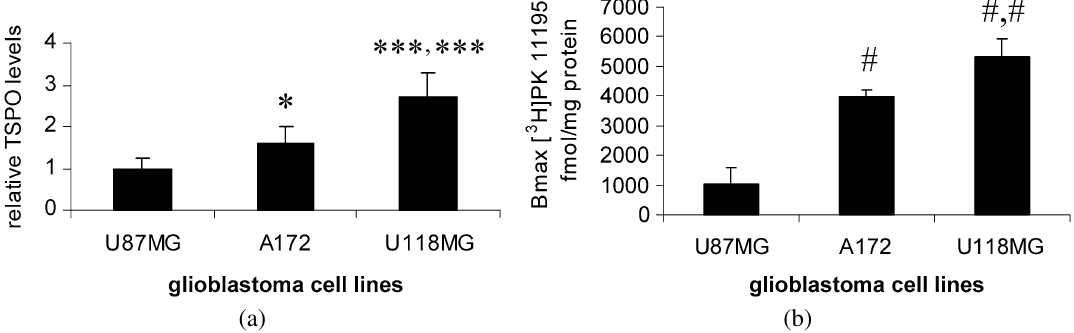
Fig. 2. (a) Densitometric measurements of average TSPO levels detected with Western blot showed statistically significant differences between the U87MG, U118MG and A172 cell lines ( n = 8, for each comparison). No statistically significant differences in protein levels of β -actin, VDAC and ANT2 were observed ( n = 8, for each comparison). (b) The average B max ’s of [ 3 H]PK 11195 binding, were statistically significant different between the U87MG, U118MG and A172 cell lines ( n = 5, for U87MG and n = 4 for U118MG and A172). Explanation of symbols: ∗ p < 0 . 05 vs. U87MG; ∗∗∗ , ∗∗∗ p < 0 . 001 vs. U87 MG and A172; # p < 0 . 05 vs. U87MG; #,# p < 0 . 05 vs. U87MG and U118MG.